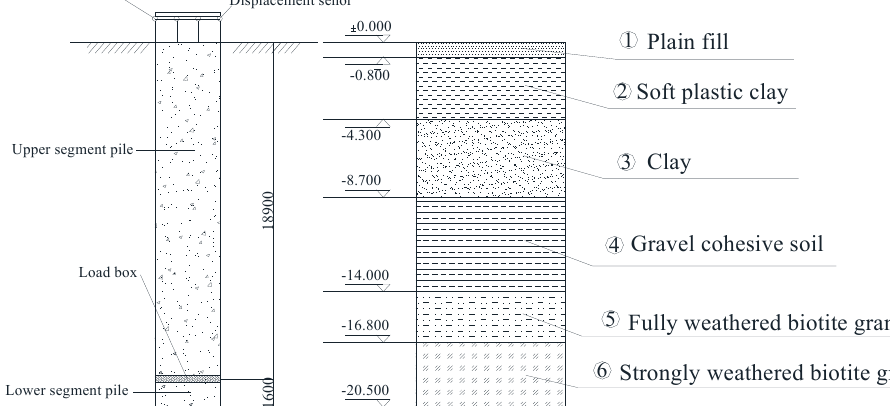
Figure 13. Self-balanced method load test soil layer distribution diagram.